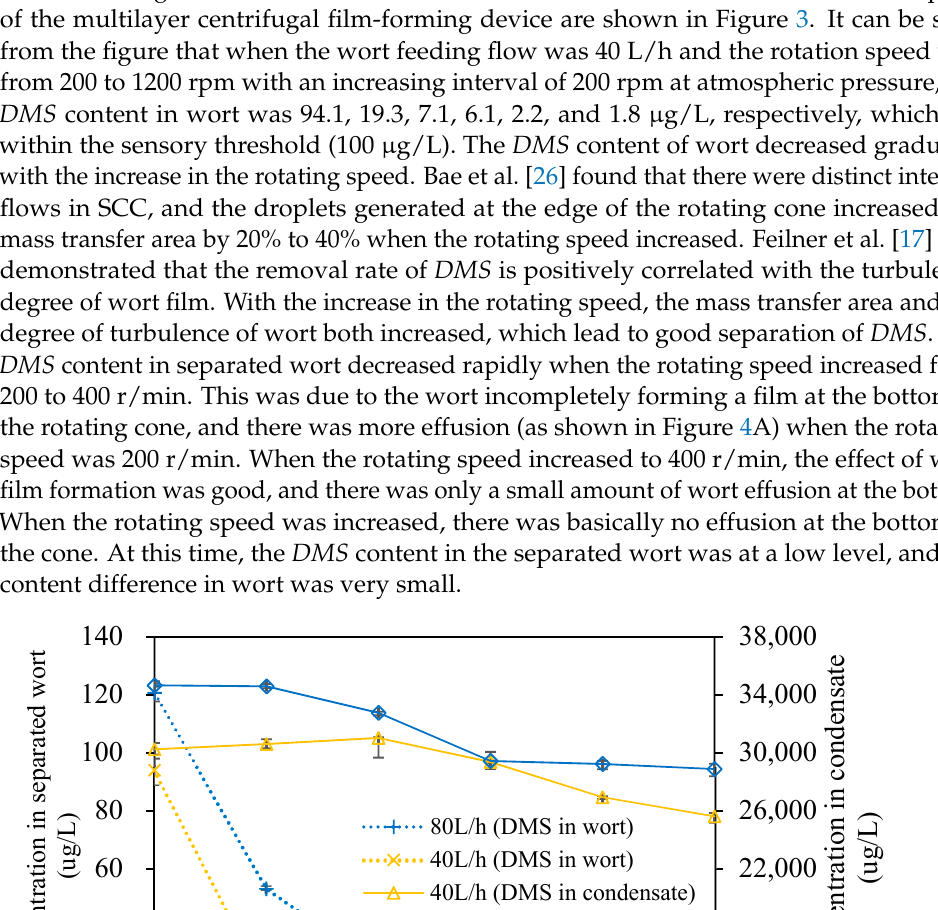
Figure 4. Film forming characteristics of wort at different speeds: ( A ) 40 L/h; ( B ) 80 L/h. It can be seen from Figure 3 that the DMS content in wort was 120.8 53.3, 26.2, 16.8, 7.6, and 5.3 μ g/L, respectively, when the wort feeding flow was 80 L/h and the rotation speed ranged from 200 to 1,200 rpm with an increasing interval of 200 rpm at atmospheric pressure. With the increase in the rotating speed, the DMS content in wort decreased grad ‐ ually, which is consistent with the trend observed when the wort feeding flow was 40 L/h. The DMS content in separated wort decreased rapidly when the rotating speed increased from 200 to 600 r/min. When the rotating speed was 200 r/min, the DMS content in wort was slightly higher than the sensory threshold (100 μ g/L). As can be seen from Figure 4B, there was more wort effusion in the cone bottom, and this meant that the film ‐ forming effect was poor, so the separation effect of DMS in wort was poor when the rotating speed was 200 and 400 r/min. When the rotating speeds were the same, the larger the feeding flow, the higher the DMS content in wort. This is because the thickness of the wort film on the rotating cone and the fixed cone of the multi ‐ layer centrifugal film ‐ forming device increased with the increase in the feeding flow rate, which led to an increase in the migra ‐ tion resistance of DMS in liquid wort. In addition, due to the low inlet temperature when the feeding flow rate was 40 L/h, the relative volatility of the volatile components was slightly higher [17], which also intensified this trend. The above analyses show that the multi ‐ layer centrifugal film ‐ forming device had a good separation effect on DMS in wort. When the rotating speed was 400 r/min, the DMS content in wort was far lower than the sensory threshold, so it was not significant to continue to increase the rotating speed. The secondary steam produced by self ‐ evaporation of the wort was condensed, and its DMS content was also detected, which is shown in Figure 3. It can be seen from the figure that when the wort feeding flow was 40 L/h and the rotation speed ranged from 200 to 1200 rpm with an increasing interval of 200 rpm at atmospheric pressure, the DMS